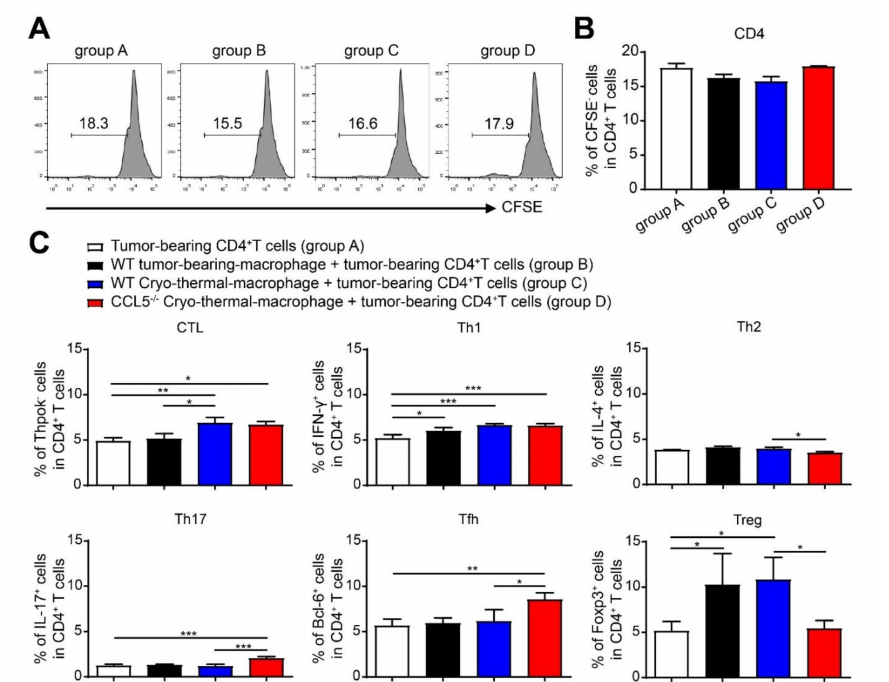
Figure 7. CCL5-deficiency-enhanced M1 polarization was required to inhibit CD4 + T cell differentia- tion into Th2 and Tregs in vitro. Splenic CD4 + T cells from WT control mice were pre-treated with CFSE and then co-cultured with macrophages from the WT control, treated WT, or CCL5 − / − mice in vitro for 24 h. The gating strategy ( A ), CFSE − CD4 + T cells ( B ), and the proportion different CD4 + T cell subsets ( C ) were analyzed with FACS. n = 4; mean ± SD. The data were analyzed with FlowJo 7 and processed using one-way ANOVA in GraphPad prism 9, * p < 0.05; ** p < 0.01; *** p < 0.001.